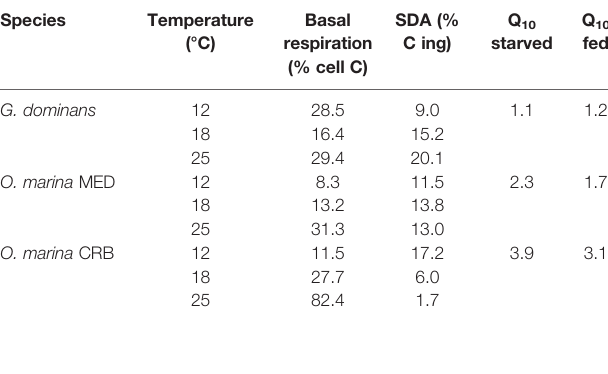
TABLE 2 | Metabolic balance of the three protozoans studied at the three selected temperatures. Species Temp.